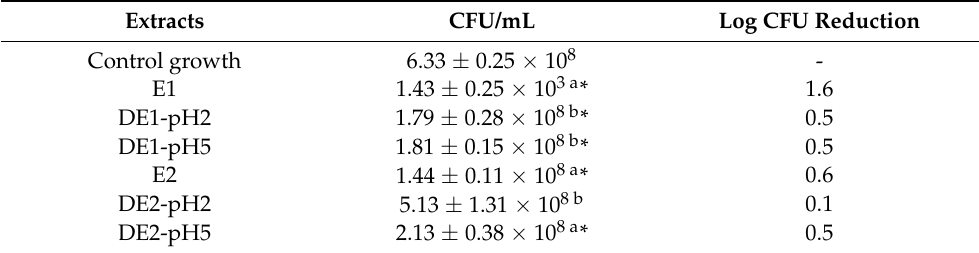
Table 2. Antibacterial activity of olive leaf extracts (E1 and E2) and their digested samples at pH 2 and pH 5 against H. pylori . Results represent the mean ± standard deviation of colony forming units (CFU)/mL (n = 3).